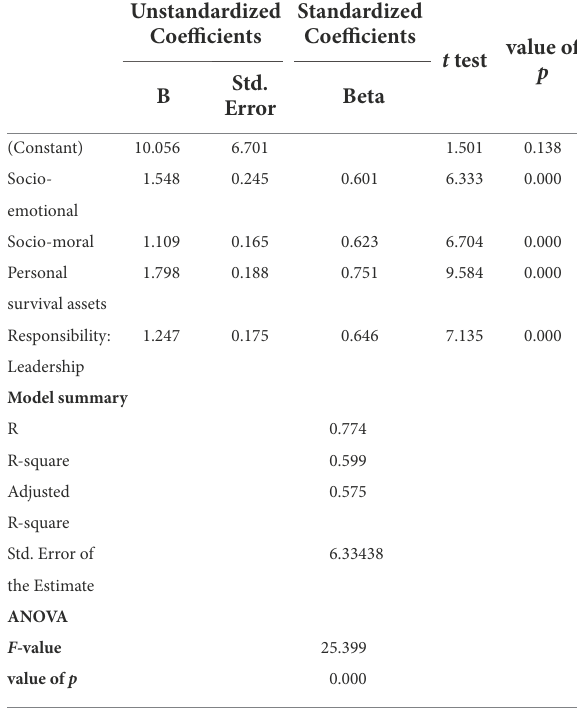
TABLE 6 Regression analysis estimating the effect of resilient cultural practices on cognitive strategy. Unstandardized